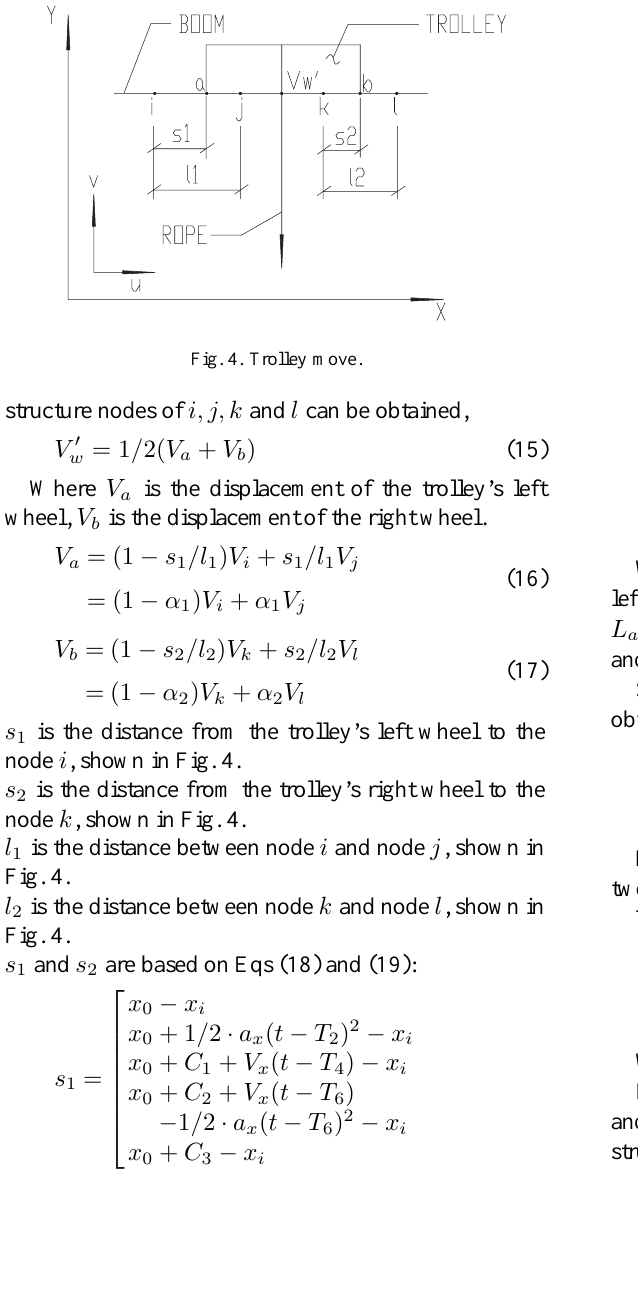
Fig. 5. Elevation of